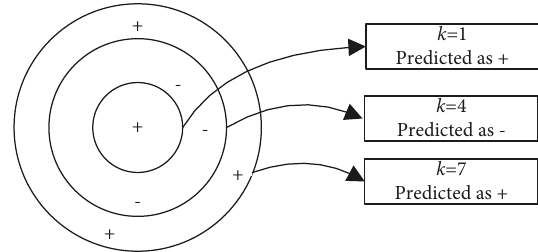
Figure 3: Schematic diagram of K-nearest neighbor